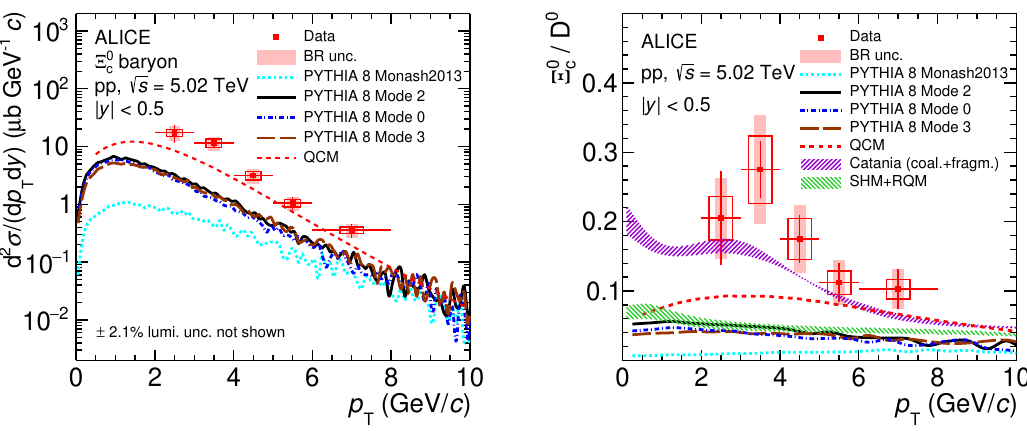
Figure 6 . Left panel: p T -differential production cross section of prompt Ξ 0 √ at s = 5.02 TeV compared with model calculations [28, 31, 36]. Right panel: Ξ 0 function of p T measured in pp collisions at 31, 32, 36, 37] (see text for